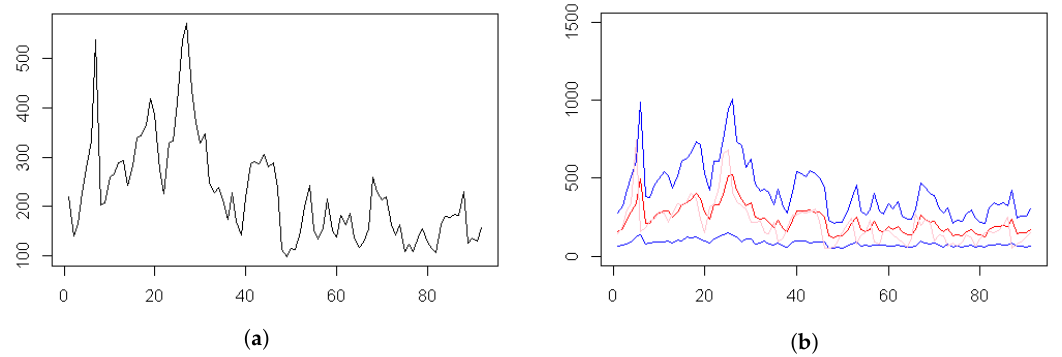
Figure 12. Prediction for the first season of 2020. ( a ) The predicted σ t . ( b ) The regional smog extremes, where the light red line denotes real values of Q t ( µ g/m 3 ), the dark red line denotes predicted values, and the topmost and lowest blue lines are 95% prediction